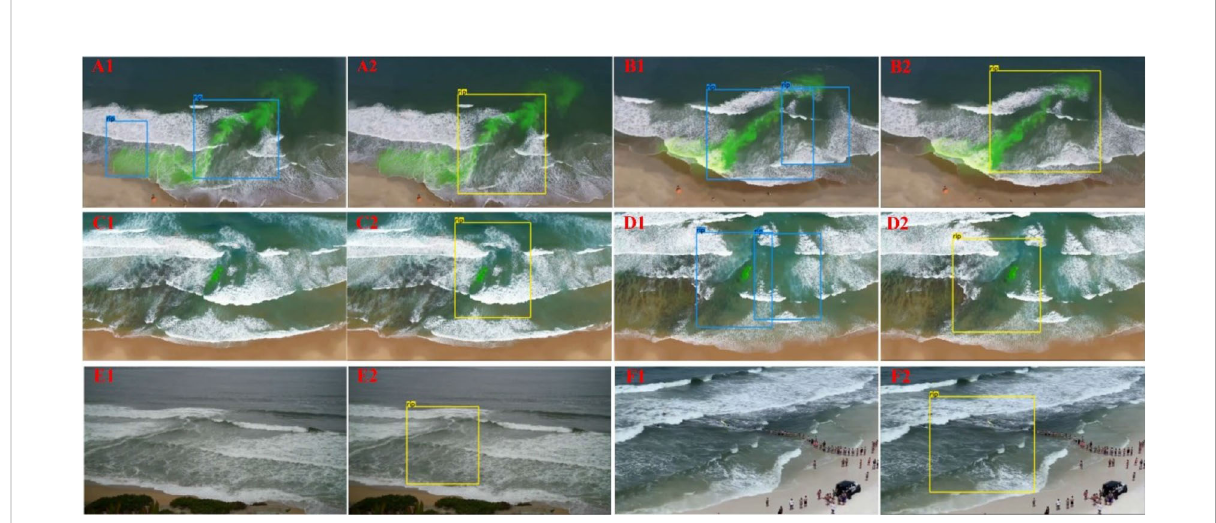
FIGURE 11 Actual detection results of YOLOv5s (blue boxes in A1 , B1 , C1 , D1 , E1 , F1 ) and YOLO-Rip ( A2 , B2 , C2 , D2 , E2 , F2 ) in selected video frames. In groups A, B, C, and D, dye was used to track rip currents and enhance the visual effect, but did not affect the detection of rip currents by the model. (Video from de Silva et